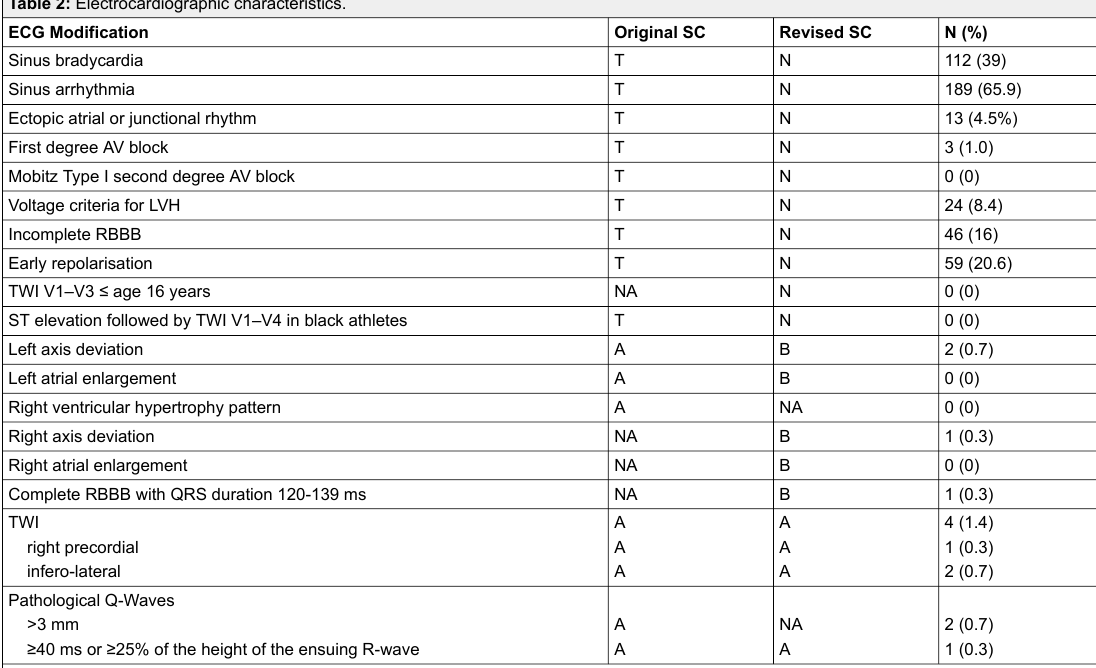
Table 2: Electrocardiographic characteristics.